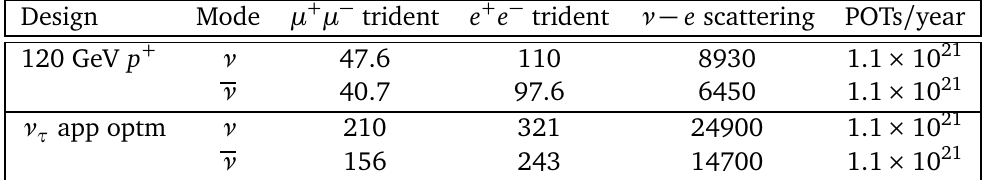
Table 18.1: The SM rates for neutrino trident production and neutrino-electron scat- tering per year at the 75-t DUNE ND after kinematical cuts. The two different rows stand for different assumptions regarding the neutrino flux, the second row corre- sponding to a higher neutrino energy